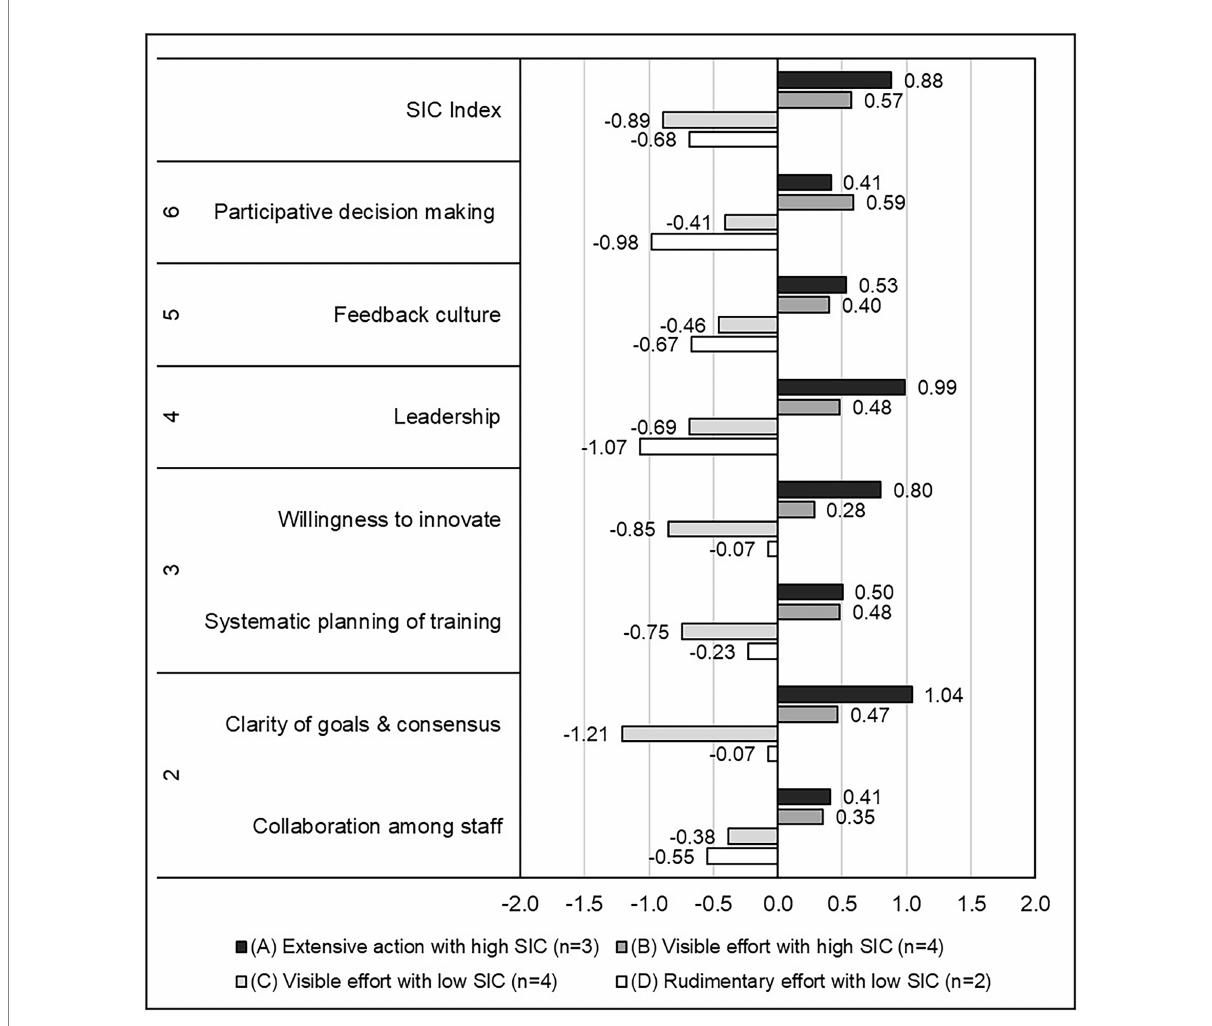
FIGURE 2 Group means of SIC . All variables were standardized ( M = 0, SD =